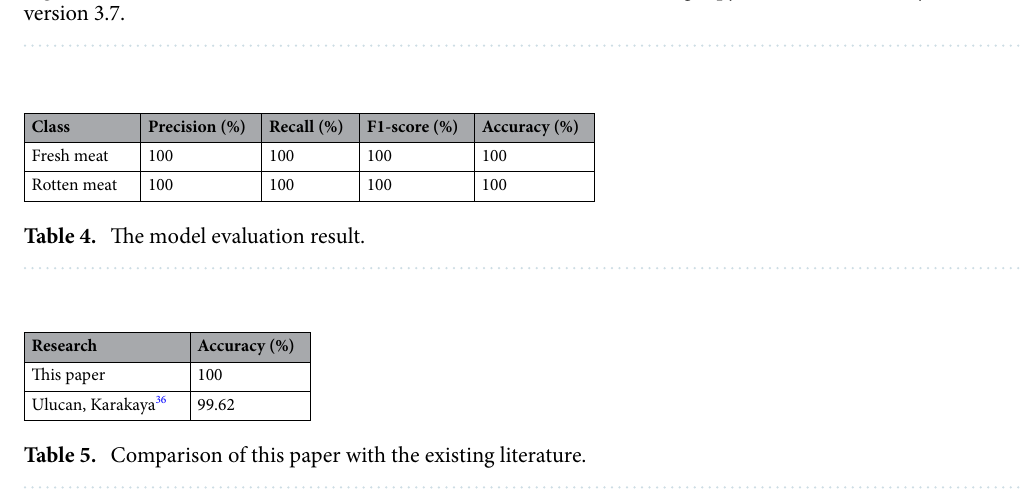
Figure 6. The confusion matrix result. Source: Authors’ construction using Jupyter Notebook, and Python version 3.7.